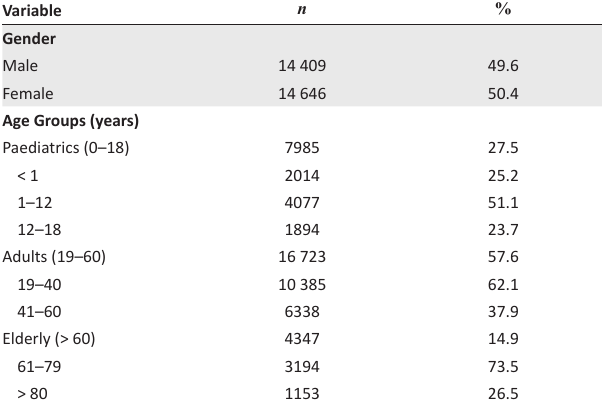
TABLE 1: Patient demographics of a private emergency centre in Pretoria for the year 2018. Variable n %